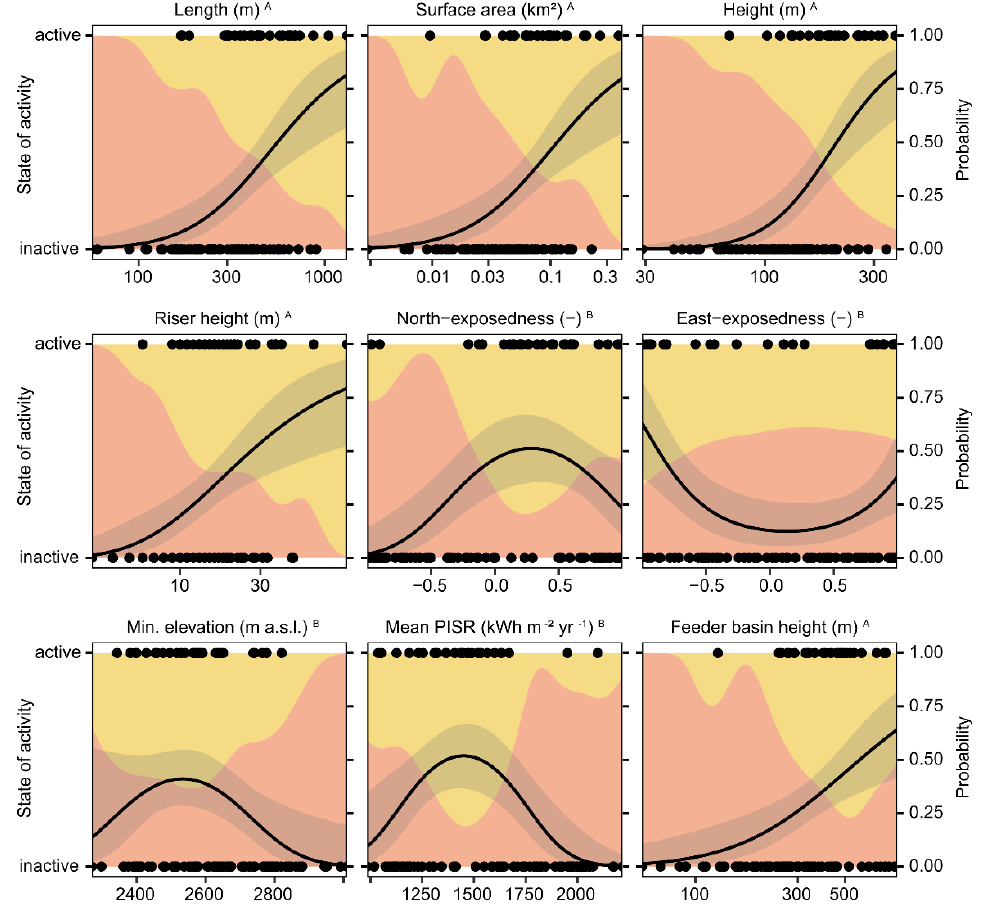
Figure 7. Conditional density distributions of rock glacier activity in relation to selected terrain parameters. Yellow and red areas correspond to conditional densities of active and inactive features, respectively; black points represent observations. Black lines and shaded areas show probability predictions and 95% confidence intervals from binary logistic regressions with either (A) logarithmic transforms or (B) polynomial transforms (two degrees of freedom) of the predictor. Only significant links (p ≤ 0.05) are shown.